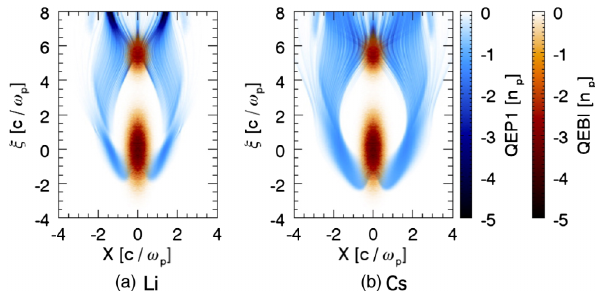
FIG. 8. Snapshot of a two-bunch PWFA in (a) a field-ionized Li plasma (b) a field-ionized Cs plasma. The plasma electron density has the blue color and the beam density is in